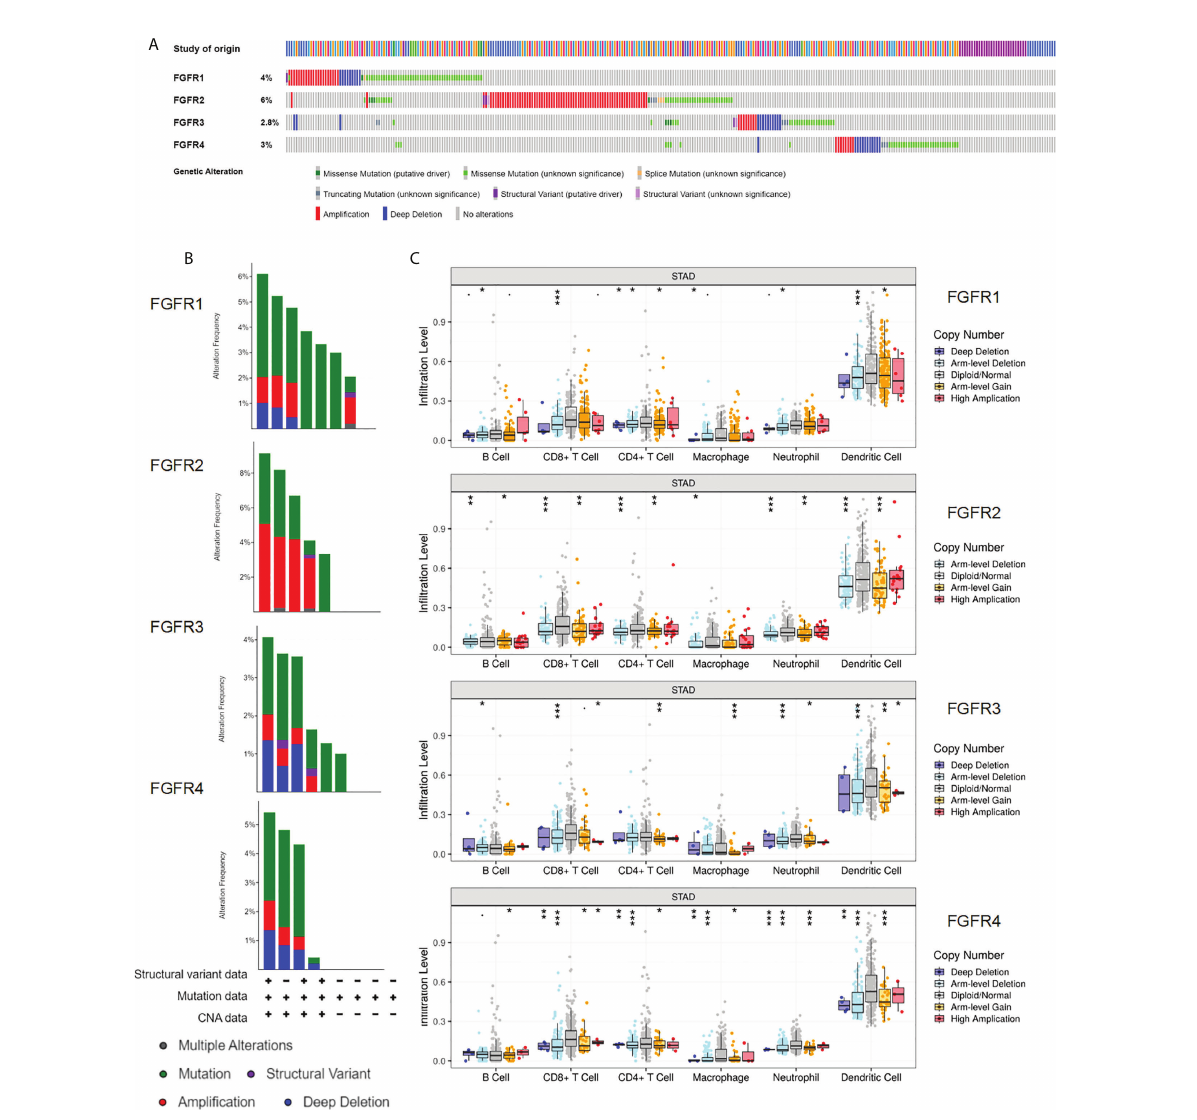
FIGURE 6 Genomic alterations of the FGFR family in GC. (A, B) The types and frequencies of FGFR family alterations in the GC samples through the cBioportal database. (Data base selected: TGCA, Nature 2014; TCGA, Firehose Legacy; TCGA, PanCancer Atlas; MSK,2020; UHK, Nat Genet 2011; Pi fi zer and UHK, Nat Genet 2014; U Tokyo, Nat Genet 2014; TMUCIH, PNAS, 2015. (C) Association between FGFRs gene copy number and immune cell in fi ltration levels in TCGA-STAD cohorts. *p < 0.05; **p < 0.01; ***p < 0.001; GC, gastric